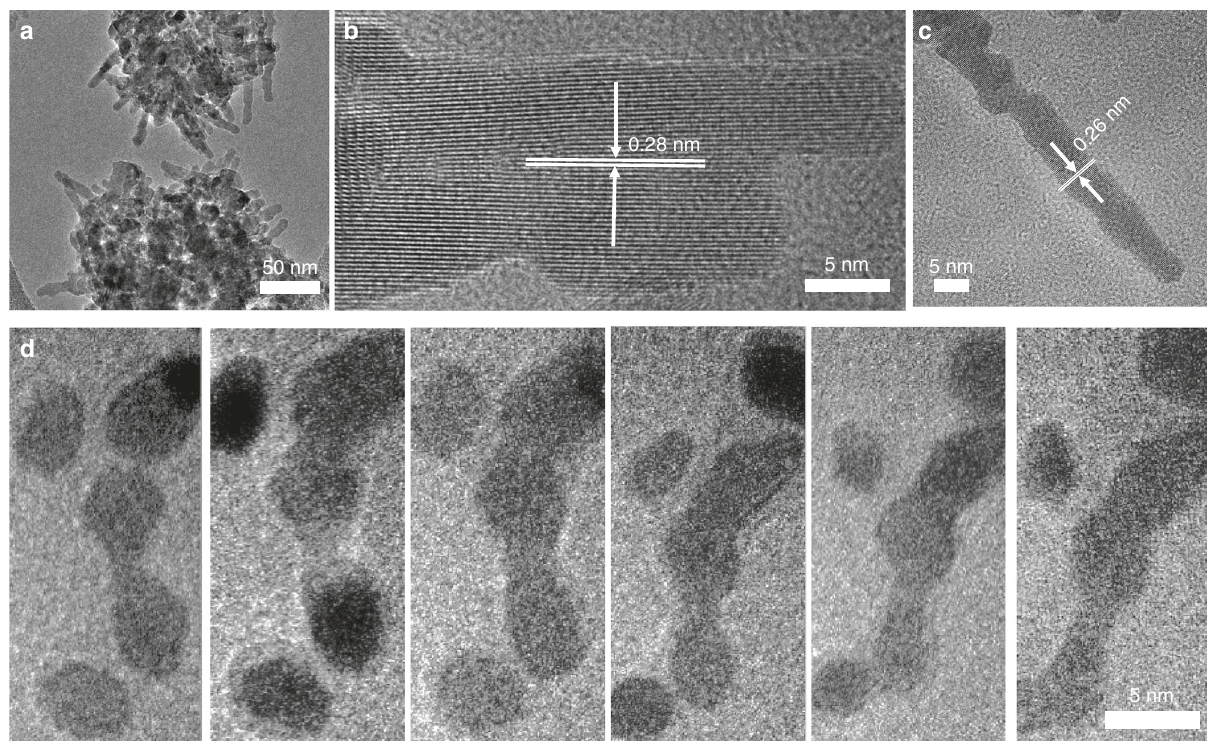
Fig. 1 Zinc oxide nanostructures grown from solution. a – c Ex situ TEM images of ZnO grown in methanol solution containing 1 mM Zn 2 + . d In situ LP-TEM images of growth of ZnO chain structure in methanol solution containing 1 mM Zn 2 + . Scale bar represents 5